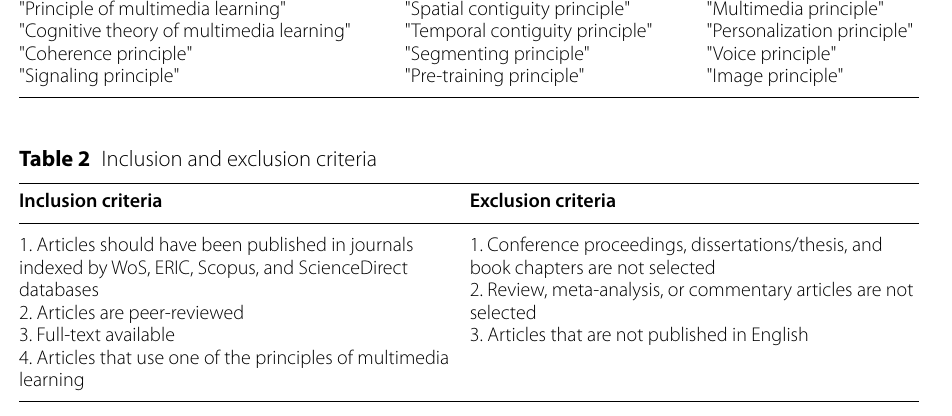
Table 1 Keywords used with the “OR” boolean operator "Multimedia learning principle” "Principle of multimedia learning" "Cognitive theory of multimedia learning" "Coherence principle"